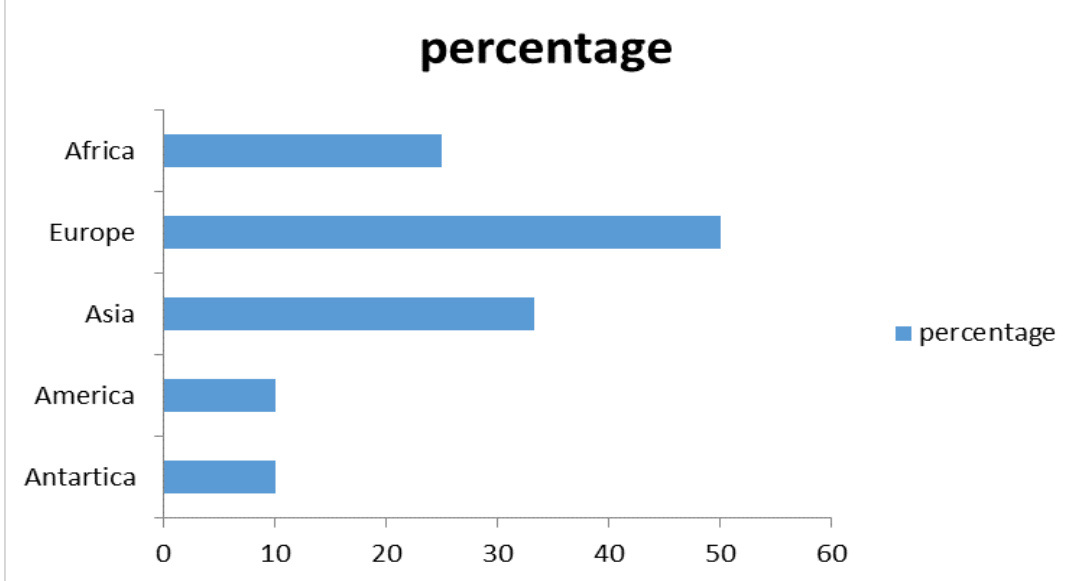
Figure 1. Percentage distribution of complete genome of M. tuberculosis bacteria per